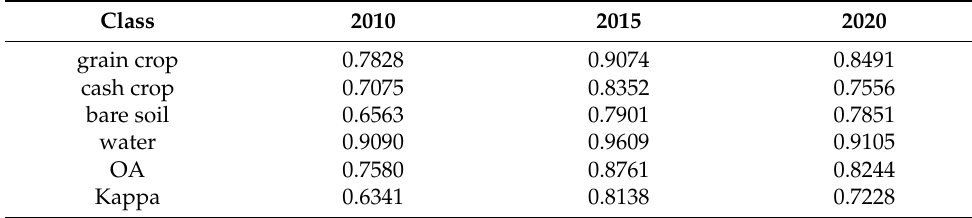
Table 3. The accuracy of crop classification results in Egypt in 2010, 2015, and 2020.